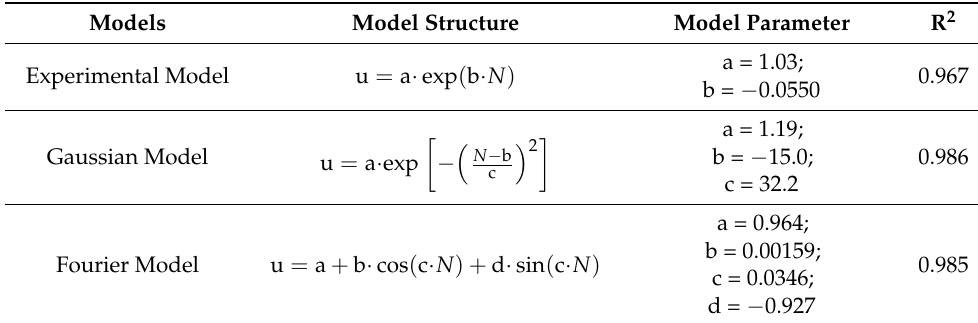
Table 3. Fitting results of drying curve data in industrial production.